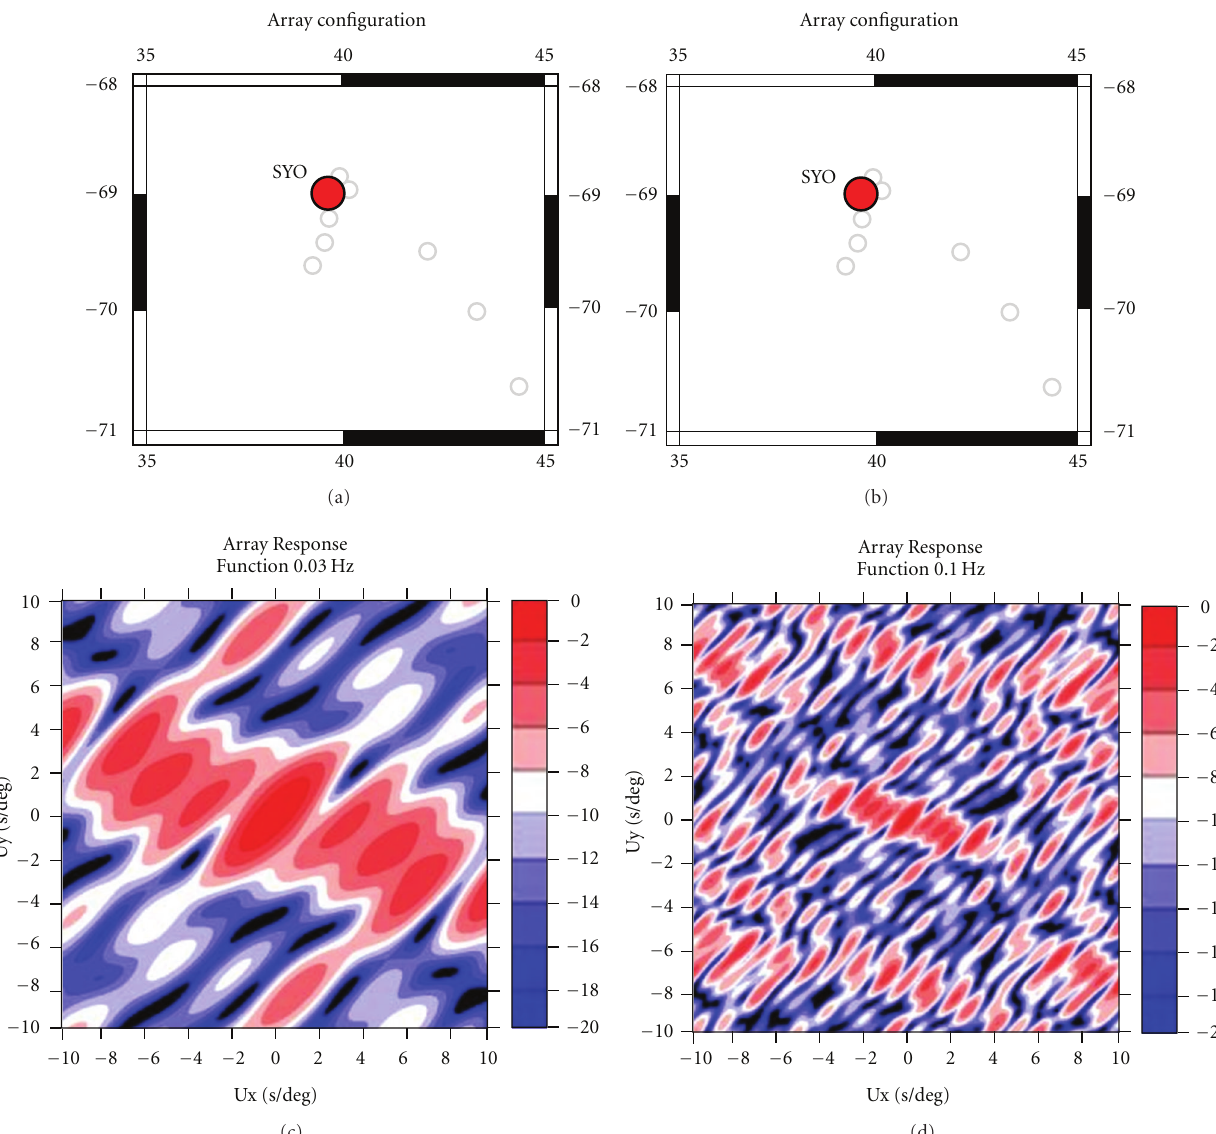
Figure 3: Simulated seismic array response functions in dominant frequency of 0.03 Hz and 0.1Hz for receiver distribution for all GARNET stations as shown in Figure